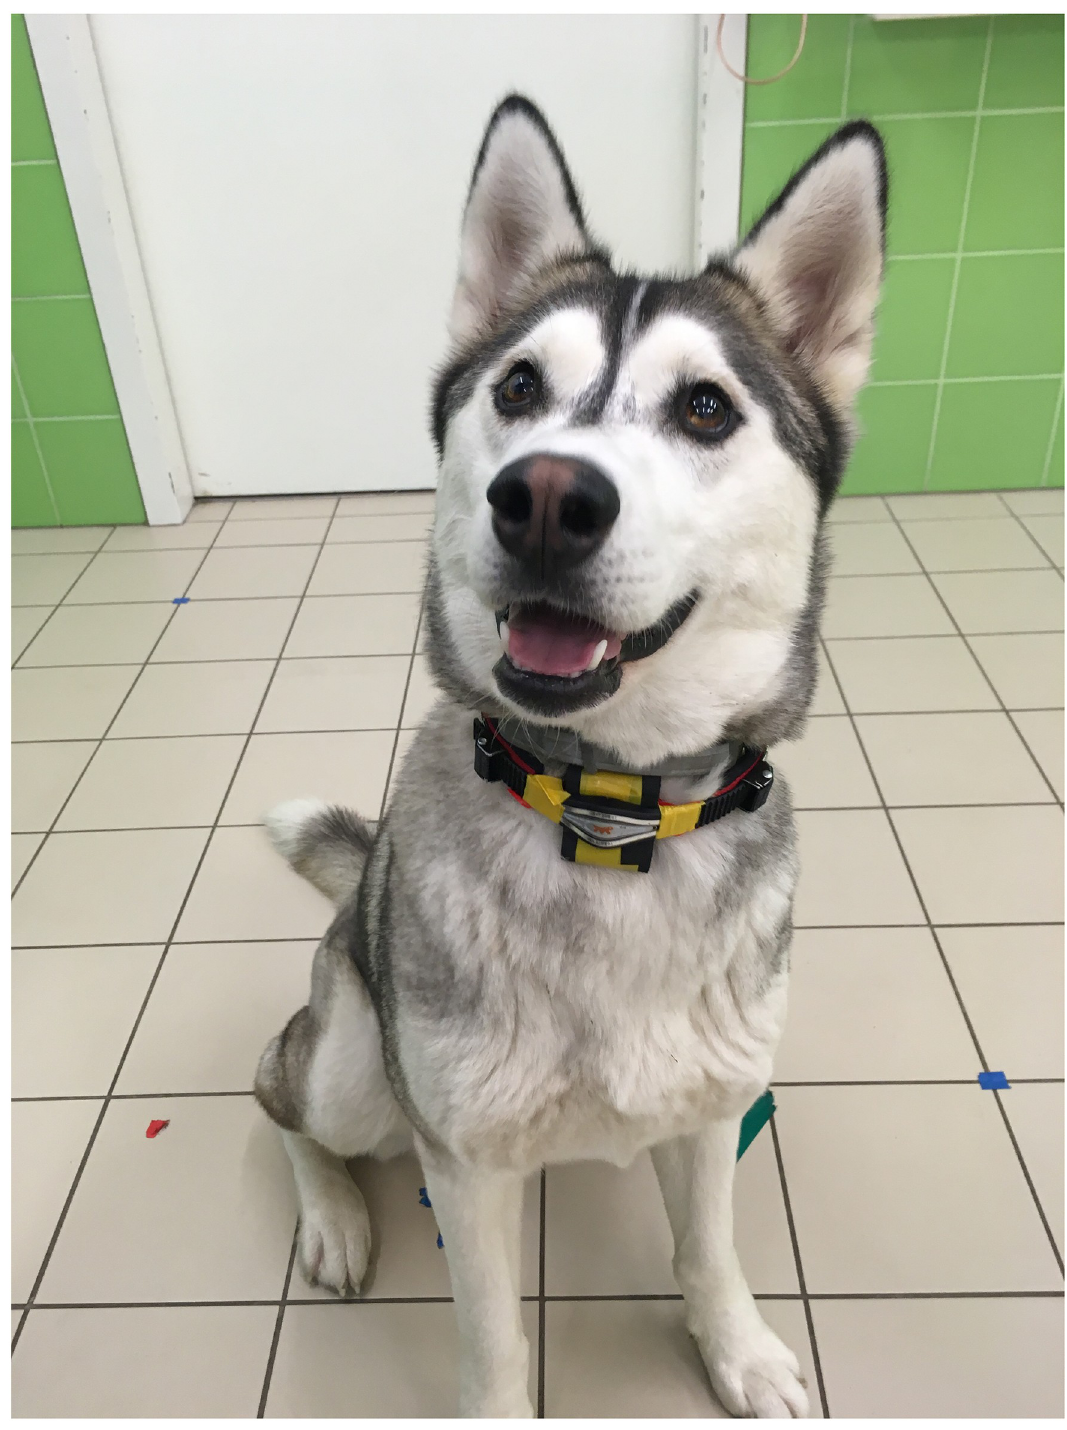
Fig 1. The custom made collar worn by a dog, with the inertial data logger installed.